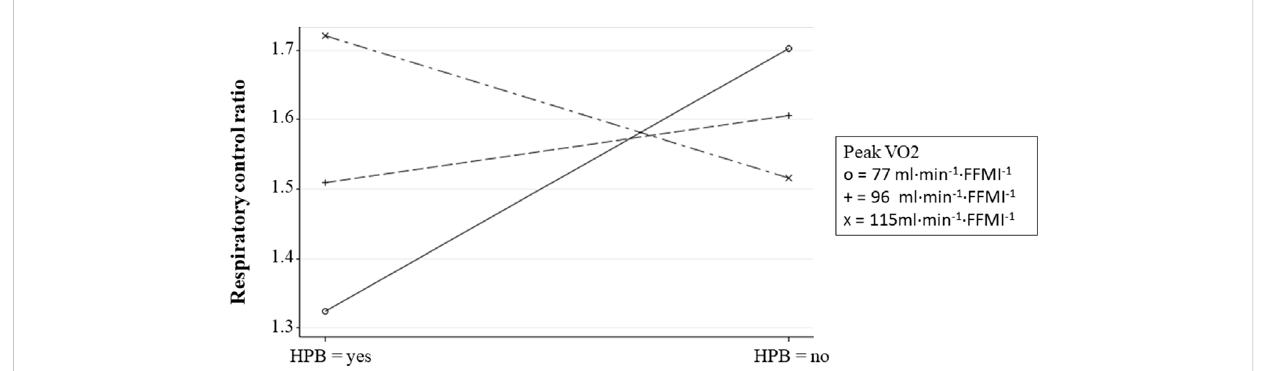
Fitted plot showing the interaction between peak _ VO 2 and high blood pressure in relation to RCR. Peak _ VO 2 — level groups were created using the group average ±